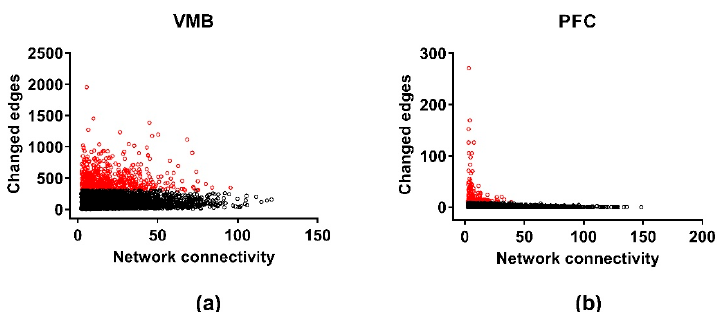
Figure 7. Differential wiring of the cospliced genes in the methamphetamine high drinking (MAHDR) and methamphetamine low drinking (MALDR) lines. To facilitate comparison across regions, the connectivity and number of edges are computed only for the genes shared in common across the brain regions. The numbers of changed edges for the cosplicing networks are shown in ( a ) for the ventral midbrain (VMB) and ( b ) for the prefrontal cortex (PFC). The nucleus accumbens (NAc) is not represented, because the data from the NAc did not follow a power law distribution, making it impossible to assess differential wiring for the cosplicing networks. Genes significantly enriched in changed edges, relative to other genes in the same network, are depicted in red.